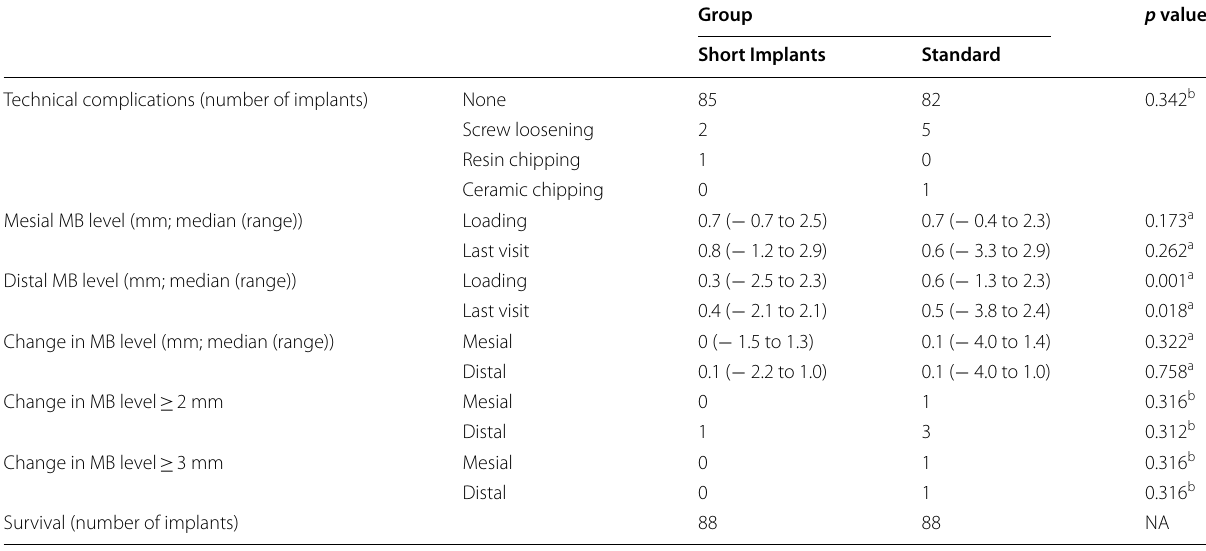
Marginal bone (MB) level (( a Mann–Whitney test b Chi square